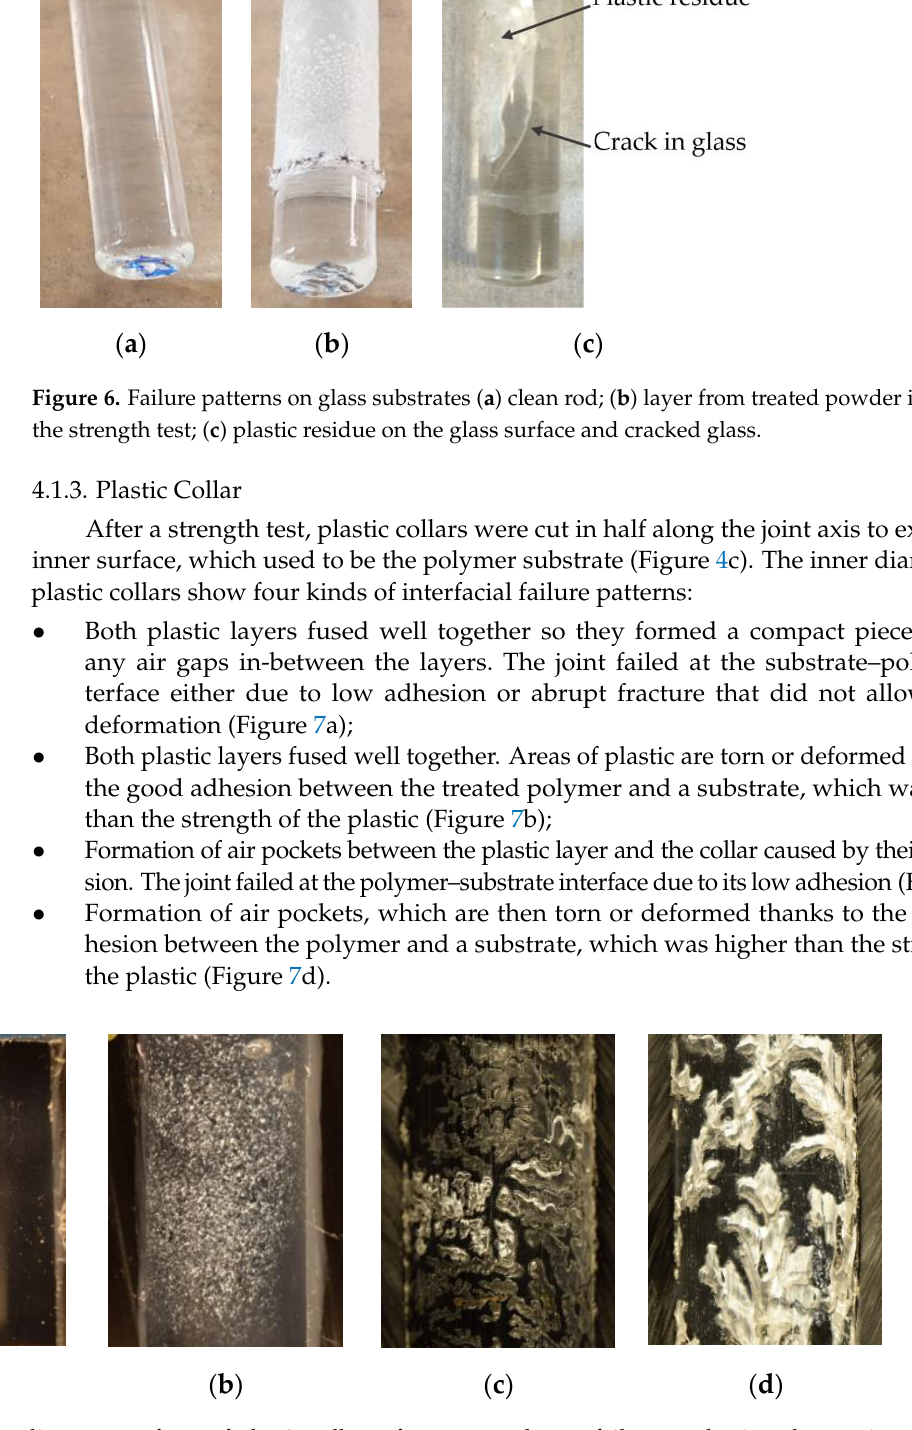
Figure 7. Details of inner diameter surfaces of plastic collars after a strength test, failure at plastic–substrate interface: ( a ) smooth inner surface ( b ) torn plastic with a hair-like structure; ( c ) air pockets in-between the plastic layer and the collar, mostly smooth surface; ( d ) locally smooth surface and torn plastic covering the air pockets.